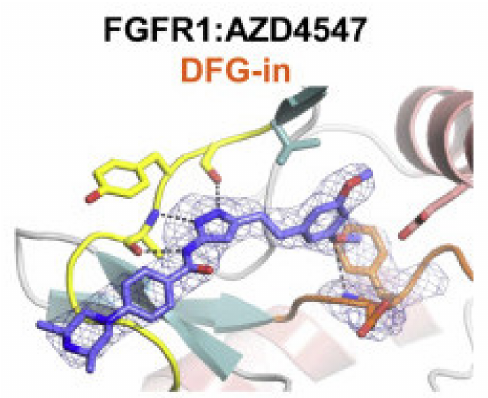
Figure 33. Binding mode of AZD4547 ( 30 ) with FGFR1 kinase crystal structure [44].